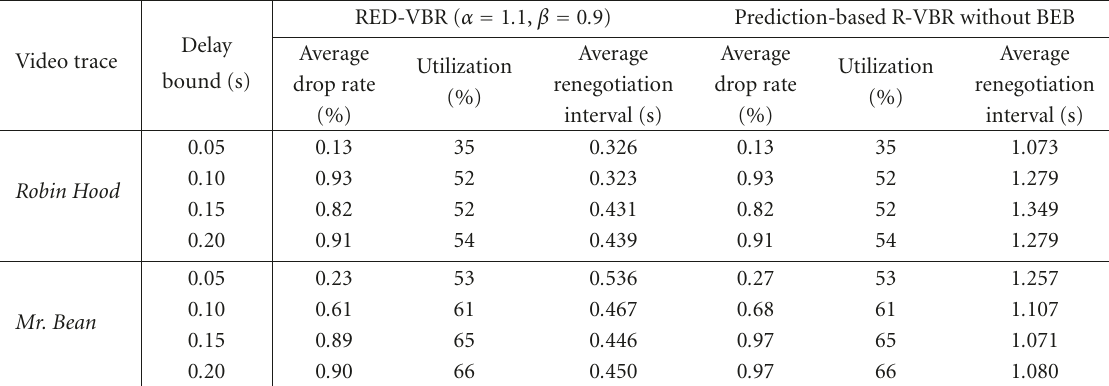
Table 2: Performance comparisons of the prediction-based R-VBR versus RED-VBR with comparable network utilization.